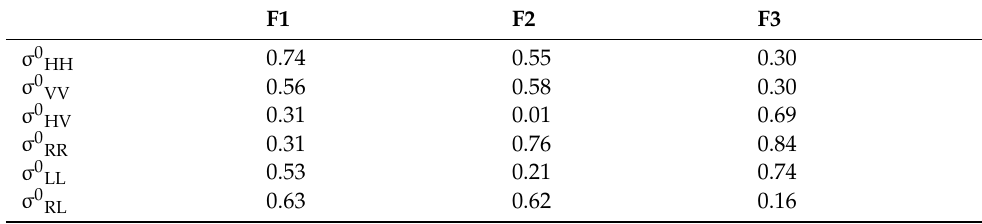
Table 8. Correlation coefficients of σ 0 vs. soil moisture at C-band for F1, F2, and F3 sites.